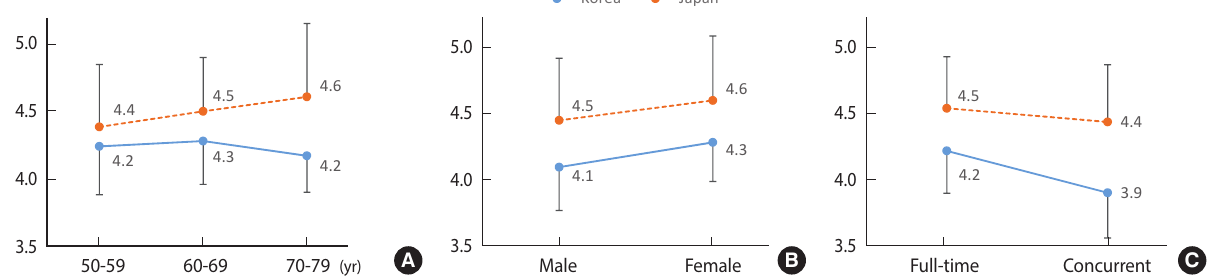
Figure 2. Differences in total average level of behavior of agriculture work according to general characteristics and country. Data were expressed as the means and standard deviation. Statistical analysis were performed using two-way analysis of variance to determine the main effects and interaction between variables. (A) F country =47.044, p<0.001; F ages =1.503, p=0.22; F country×ages =4.978, p=0.007. (B) F country =77.280, p<0.001; F sex =19.568, p<0.001; F country×sex =0.224, p=0.64. (C) F country =18.541, p<0.001; F agricultural type =4.659, p<0.05; F country×agricultural type =2.953, p=0.09.